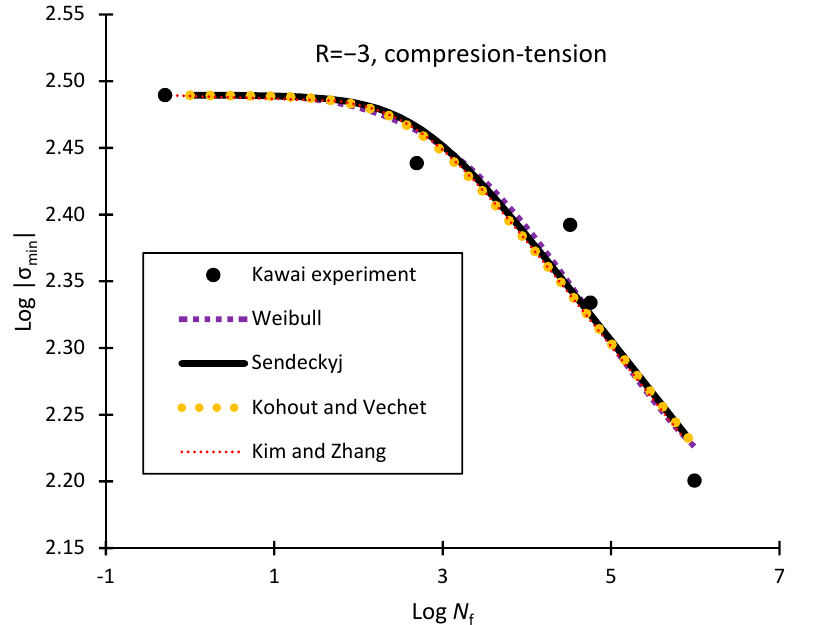
Figure 8. Kawai and Itoh experimental data [22] for carbon fiber reinforced epoxy laminates with σ uC = 807 MPa and σ uT = 1887 MPa, and S-N curves obtained from: Weibull model with α = 3.5 × 10 − 3 , β = 3.59, and assumed σ ∞ = 150 MPa; Sendeckyj model with α = 0.001985 and β = 0.08; Kohout and Vechet model with α = 398.1and β = − 0.0775; and Kim and Zhang model with α = 4.295 × 10 − 38 , β = 13.506, and N 0 = 0.5.